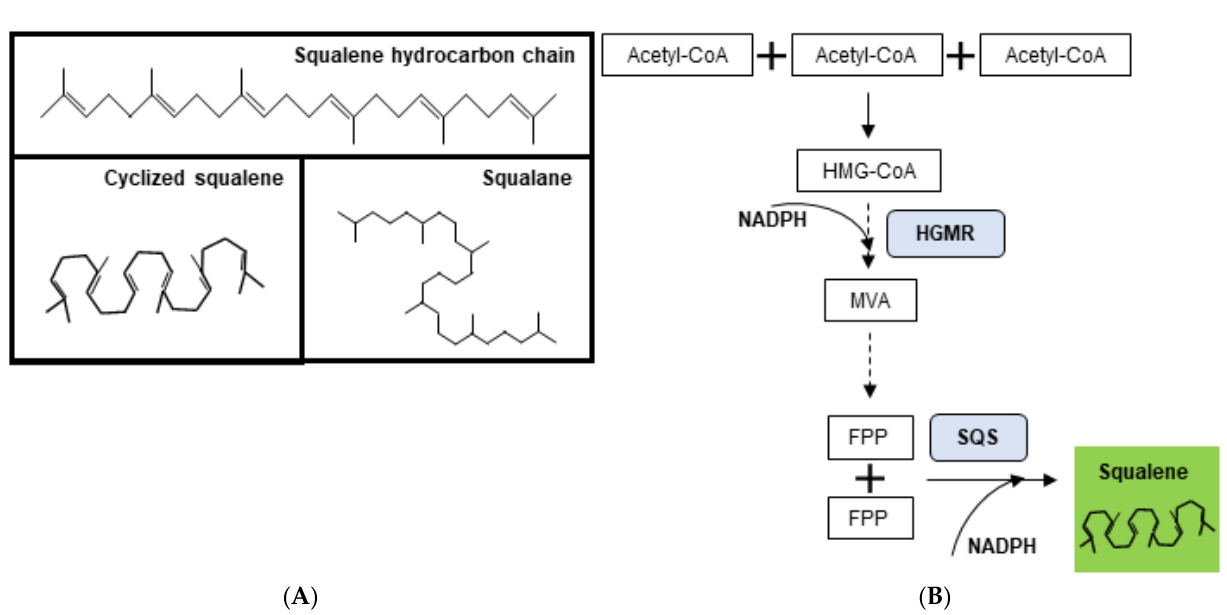
Figure 1. ( A ). Squalene and squalane. Structure and biosynthesis Squalene (2,6,10,15,19,23-hexamethyltetracosa-2,6,10,14,18,22-hexaene; C 30 H 50 ) hydrocarbon chain (top); squalene in its cyclized form (bottom left); and fully saturated squalane (bottom right). ( B ). Simplified representation of the mevalonate (MVA) pathway in eukaryotes. Acetyl-Coa: Acetyl coenzyme A; HGM-CoA: 3-hydroxy-3-methylglutaryl-CoA; HGMR: HGM-CoA reductase; MVA: Mevalonate; FPP: Farnesyl pyrophosphate; SQS: Squalene synthase; and NADPH: Nicotinamide adenine dinucleotide phosphate. Full arrow: single step reaction; dashed arrows: simplified representation of multistep reactions.